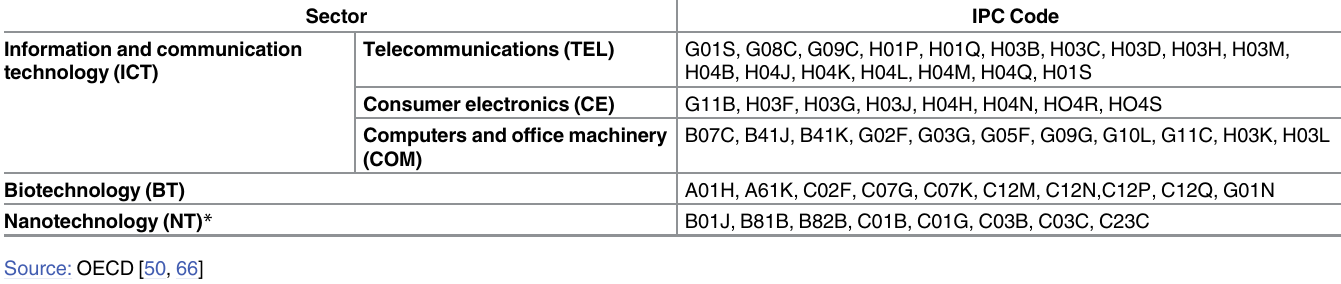
Table 4. ICT, BT, and NT Sectors by IPC